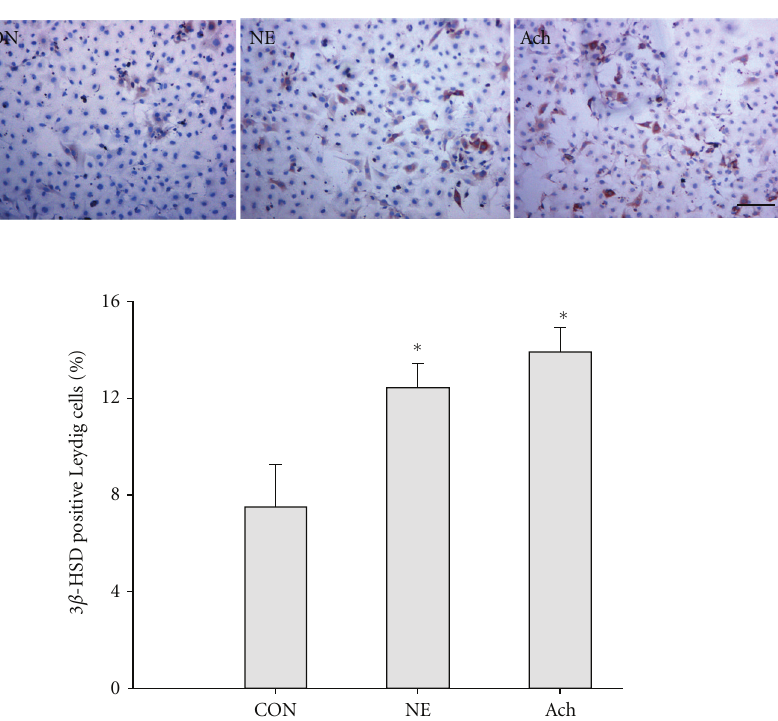
Figure 3: NE and Ach on the di ff erentiation of precursor Leydig cells into 3 β -HSD-positive Leydig cells. The percentage of 3 β -HSD-positive cells to total Leydig cells was determined and presented as means ± SEM. A single asterisks ( ∗ ) indicates statistical significance ( P < 0 . 05) relative to the untreated control. CON: control group cultured with the same dilution of NE and Ach. NE: NE group cultured in the presence of 10 μ M NE. Ach: Ach group cultured in the presence of 10 μ M Ach. Bar = 50 μ